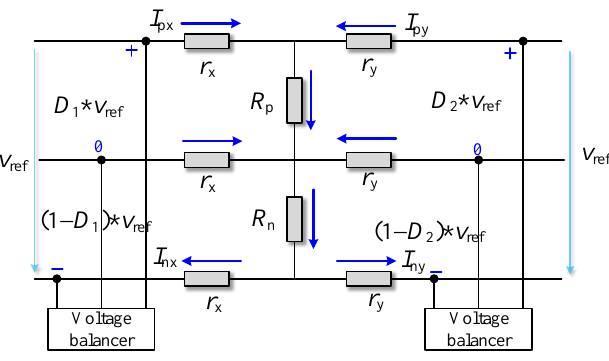
Figure 4. Simplified model of the voltage balancer.